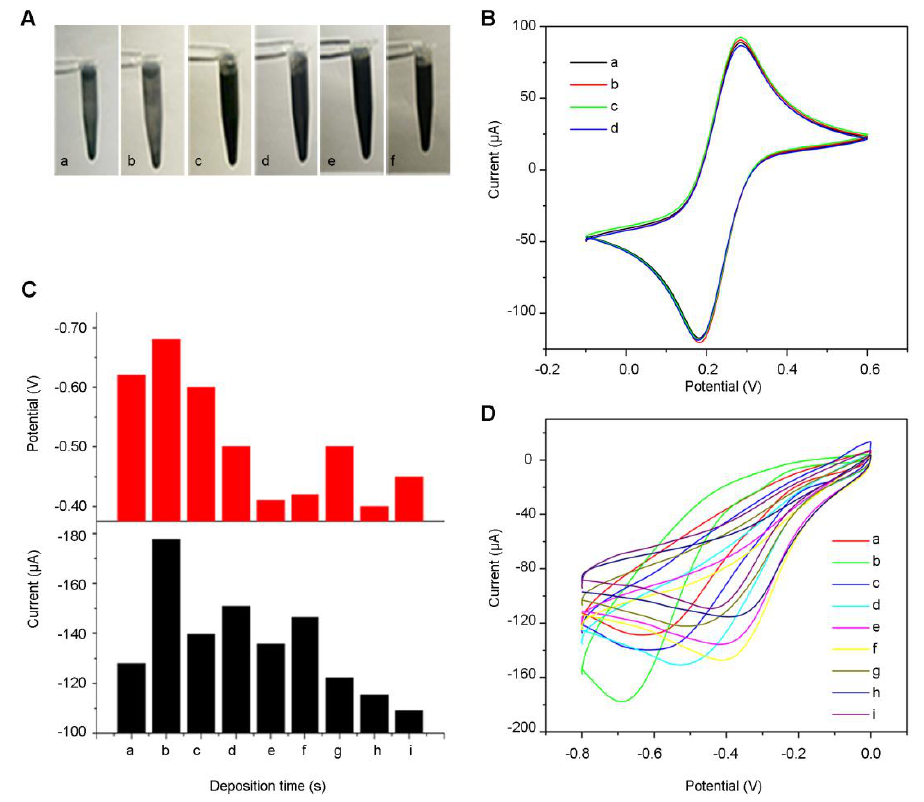
Figure 3. Optimization of experimental parameters for the fabrication of MoS 2 -Au-Ag / GCE. ( A ) MoS 2 dispersion e ff ects of 2 mg mL − 1 water (a), 2 mg mL − 1 PBS bu ff er (b), 5 mg mL − 1 0.5% PDDA (c), 5 mg mL − 1 1% PDDA (d), 2 mg mL − 1 0.5% PDDA (e) and 2 mg mL − 1 1% PDDA (f). ( B ) CV curves of dispersed MoS 2 modified electrodes in K 3 [Fe(CN) 6 ] under 2 mg mL − 1 0.5% PDDA (a), 2 mg mL − 1 1% PDDA (b), 5 mg mL − 1 1% PDDA (c), 5 mg mL − 1 0.5% PDDA (d). ( C ) The current line diagram of the electrode at 10 mM H 2 O 2 with di ff erent deposition times. ( D ) CV curves of electrode modified with di ff erent depositions time in 10 mM H 2 O 2 . Deposition time: (a) Au 30 s Ag 30 s, (b) Au 30 s Ag 90